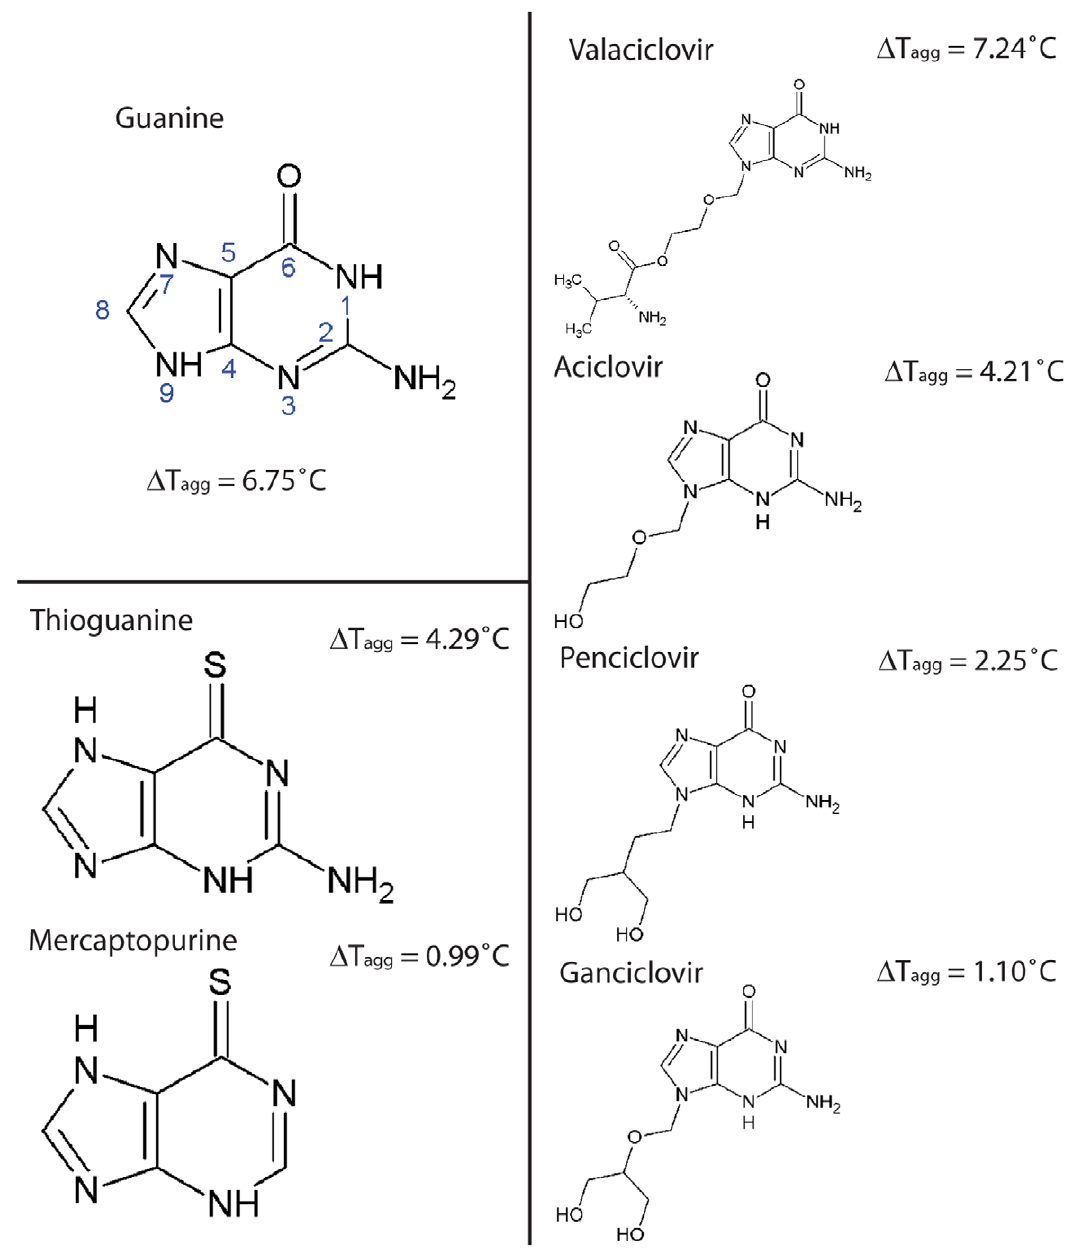
Figure 5. Ligands of GDA and mean D T agg with 1000 m M NA.